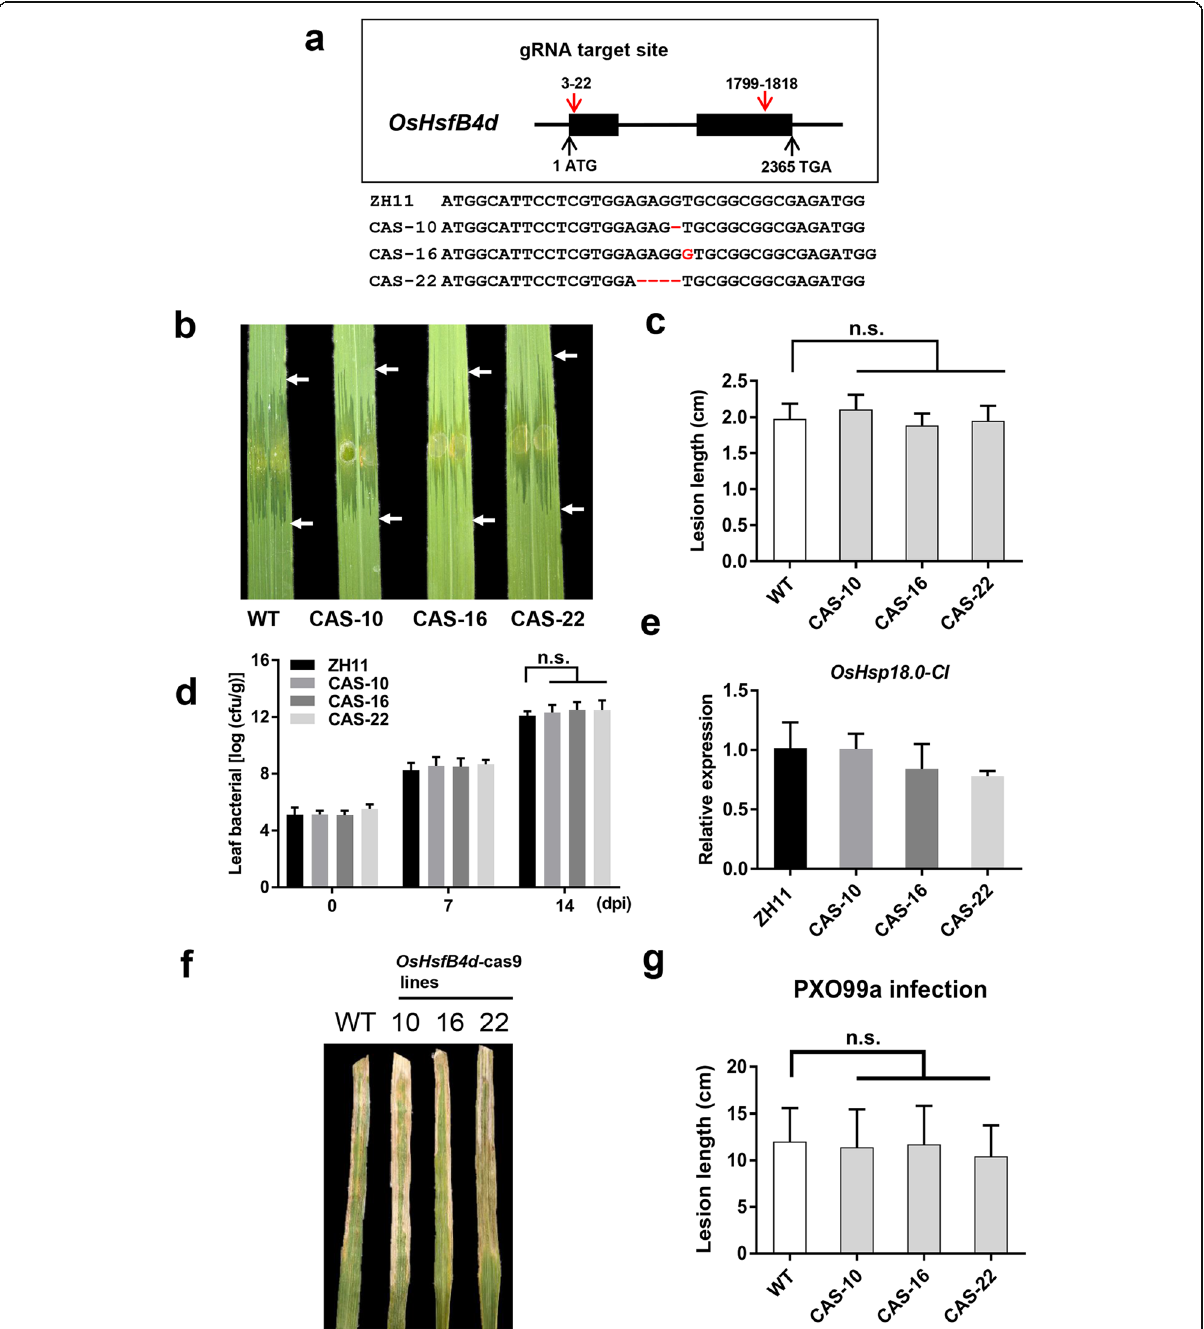
Fig. 5 Resistance performance of transgenic OsHsfB4d -cas9 plants from the T 2 generation. a Diagram of the Cas9 enzyme cleavage site and the genome editing of OsHsfB4d. Three mutation types, including a 1 base deletion, a 1 base insertion and a 4 bases deletion, were detected in the three transgenic lines. b Representative lesion sites from OsHsfB4d-cas9 plants at 14 dpi with Xoc strain RS105. c Lesion lengths in the OsHsfB4d- cas9 lines. Each line comprises seven individual transgenic plants assessed in this experiment at 6-week-old stage. “ n.s. ” means not significant according to the statistical analysis (n = 10). d Bacterial population growth in leaves of OsHsfB4d-cas9 and WT plants inoculated with RS105. The bars represent the mean ± SD. “ n.s. ” : not significant. e The transcript detection of OsHsp18.0-CI in 6-week-old wild-type and OsHsfB4d-cas9 lines. The bars represent the mean ± SD. f The phenotypes of the PXO99a lesions that developed on ZH11 and OsHsfB4d-cas9 lines at 14 dpi. g Lesion lengths were scored for OsHsfB4d-cas9 lines (n = 10). “ n.s. ” : not